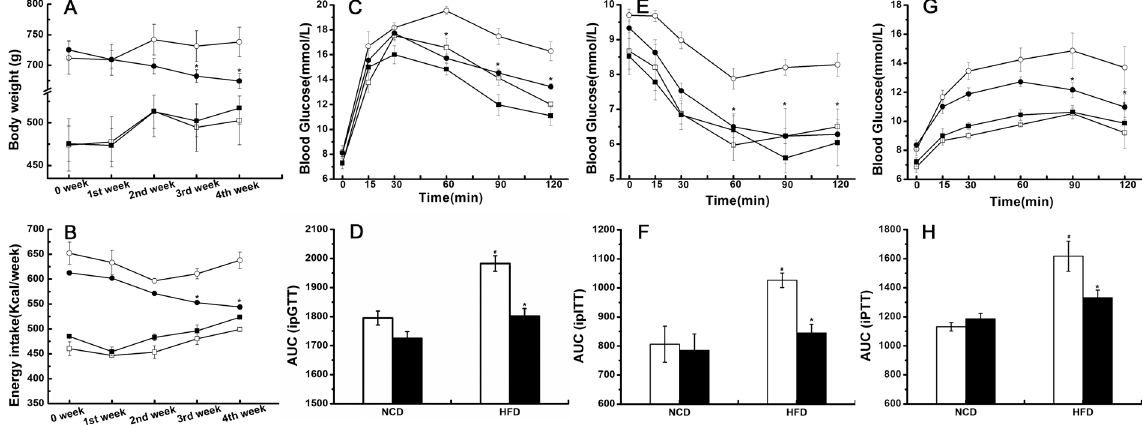
Figure 2. Down-regulation of Tlr4 mRNA expression in the hypothalamic ARC decreases body weight, energy intake, and improves glucose tolerance, insulin sensitivity and liver gluconeogenesis in obese rats. ( A ) The changes of the body weight in NCD group and HFD group after treatment with Tlr4 shRNA or scrambled shRNA lentiviral particles. ( B ) The changes of the average food intake in NCD group and HFD group after treatment with Tlr4 shRNA or scrambled shRNA lentiviral particles. ( C ) The results of intraperitoneal glucose tolerance test (ipGTT) and ( D ) respective areas under the curve (AUC). ( E ) The results of intraperitoneal insulin tolerance test (ipITT) and ( F ) respective areas under the curve (AUC). ( G ) The results of intraperitoneal pyruvate tolerance test (iPTT) and ( H ) respective areas under the curve (AUC). The white circles and squares respectively represent treatment of scrambled shRNA in HFD group and NCD group; the black circles and squares respectively represent treatment of Tlr4 shRNA in HFD group and NCD group. The white bar represents scrambled shRNA treated group, and the black bar represents Tlr4 shRNA treated group. NCD: normal chow diet group; HFD: high fat diet group; n = 7–8 per group. The results are shown as the mean ± S.E.M. # P < 0.05 for HFD group compared with NCD group; * P < 0.05 for Tlr4 shRNA treated group compared with scrambled shRNA treated